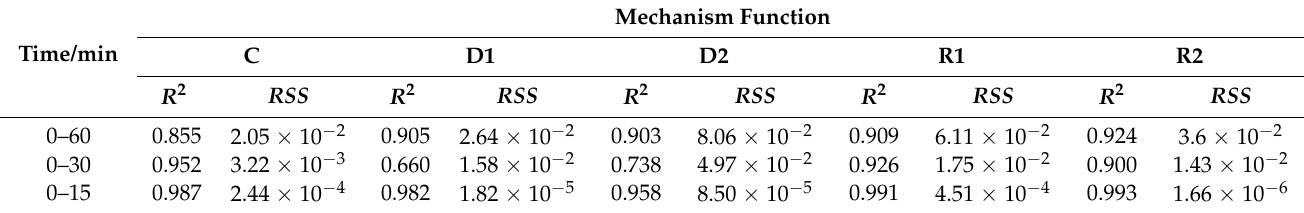
Table 4. Values of R 2 and RSS obtained from reduction ratios at 1173 K.